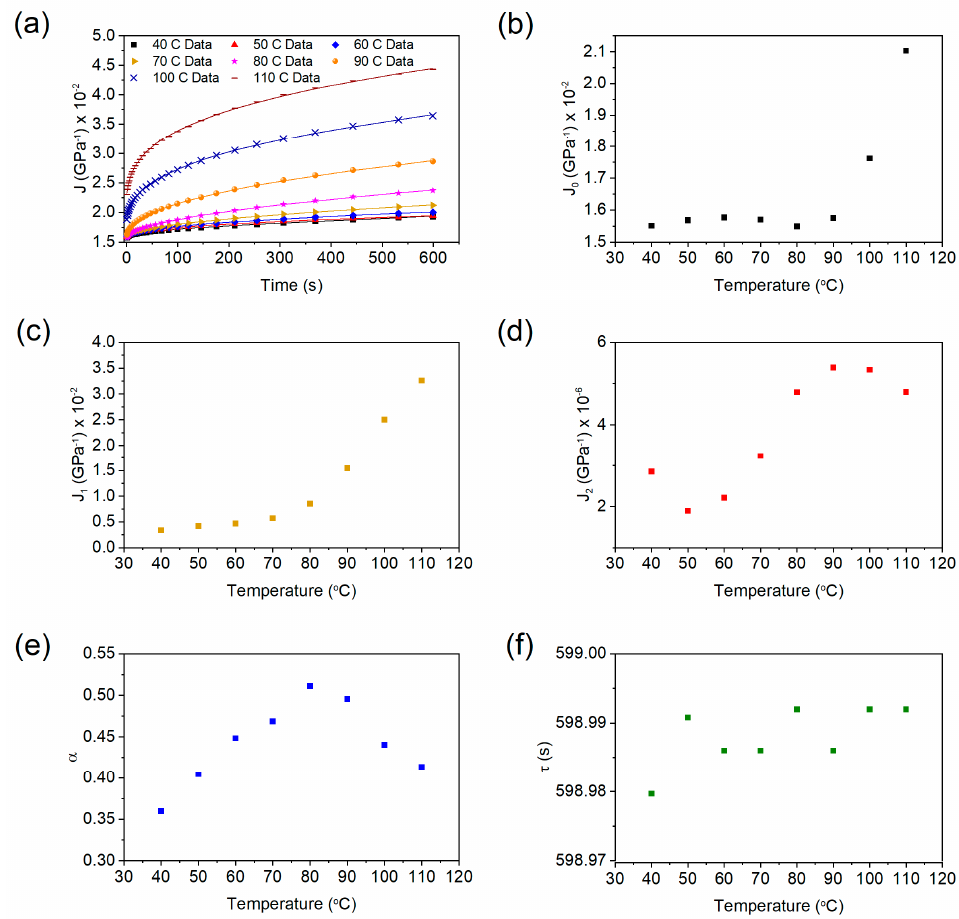
Figure 9. The fitted values for ( a ) J ( t ), ( b ) J 0 , ( c ) J 1 , ( d ) J 2 , ( e ) α , and ( f ) τ for test temperatures ranging from 40 to 110 °C.